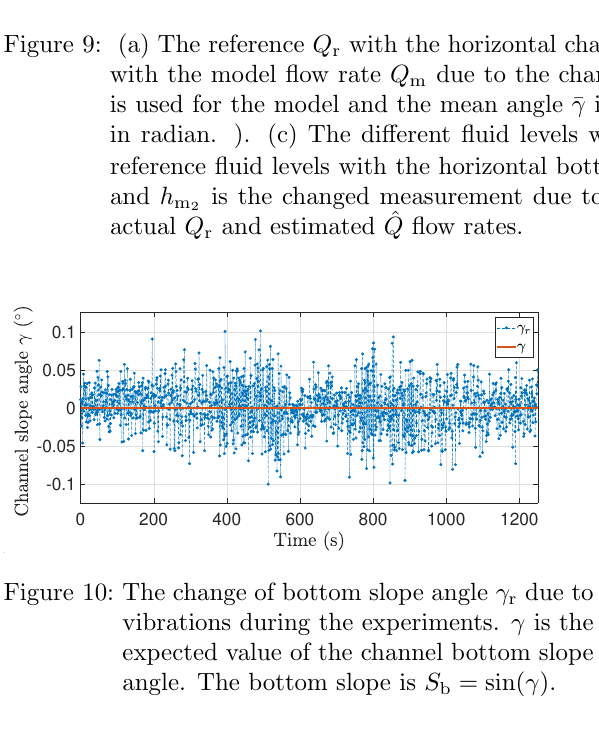
and h r are the 1 2